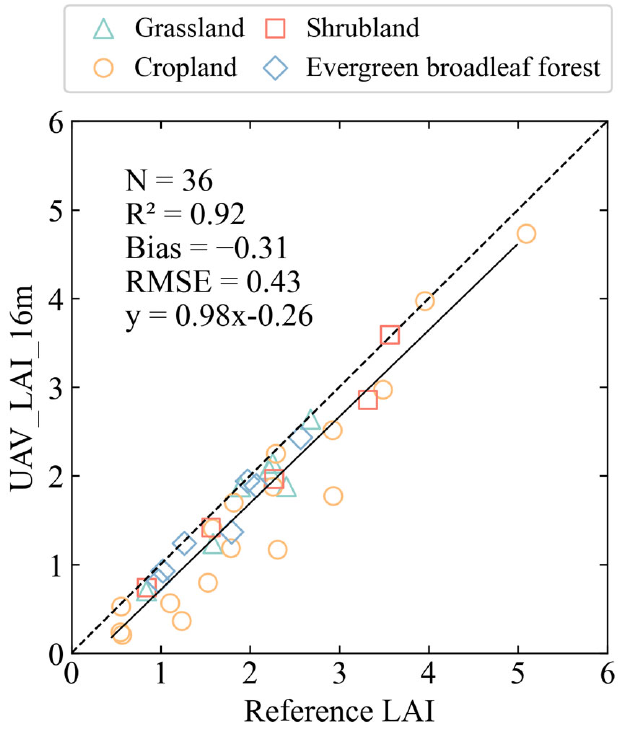
Figure 9. Scale effects analysis. Differences between Reference LAI and UAV_LAI_16m. The black dashed line indicates a 1:1 relationship and the solid line shows the linear regression between Reference LAI and UAV_LAI_16m.